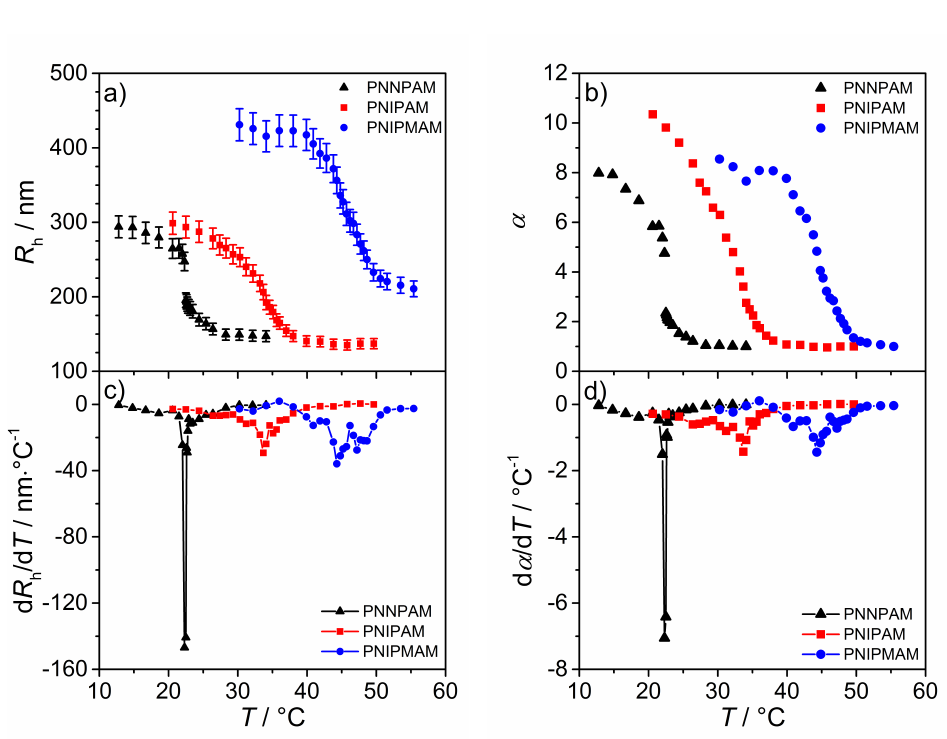
Figure 8. The swelling curves show the change of the microgel hydrodynamic radius ( a ) and the swelling ratio α ( b ) as a function of temperature for all three homopolymers. The graphs ( c ) and ( d ) represent the numerically calculated first derivative of the swelling curves. The point of inflection is the volume phase transition temperature (VPTT) of the